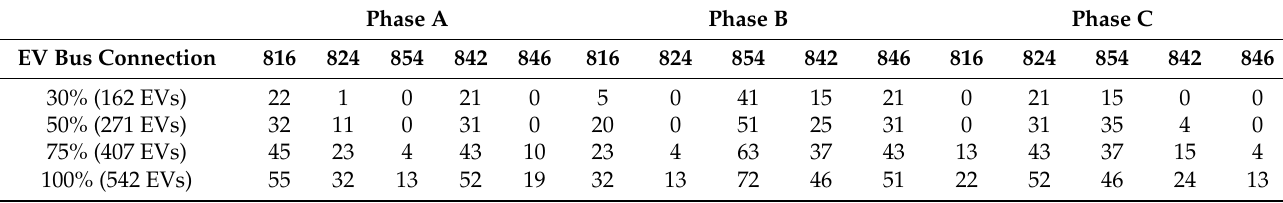
Table 2. EV penetration for different phases and